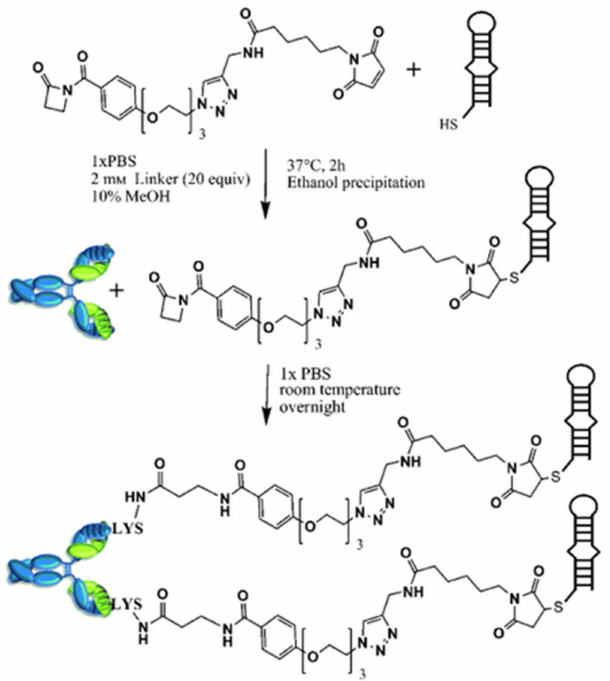
Figure 3. Irreversible programming of aldolase antibody 38C2 with aptamer ARC245 [124]. (Repro- duced with copyright permissions from 10.1002/anie.201001736. accessed on 29 July